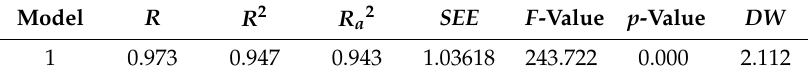
Table 2. Summary of the regression model based on the enter model.